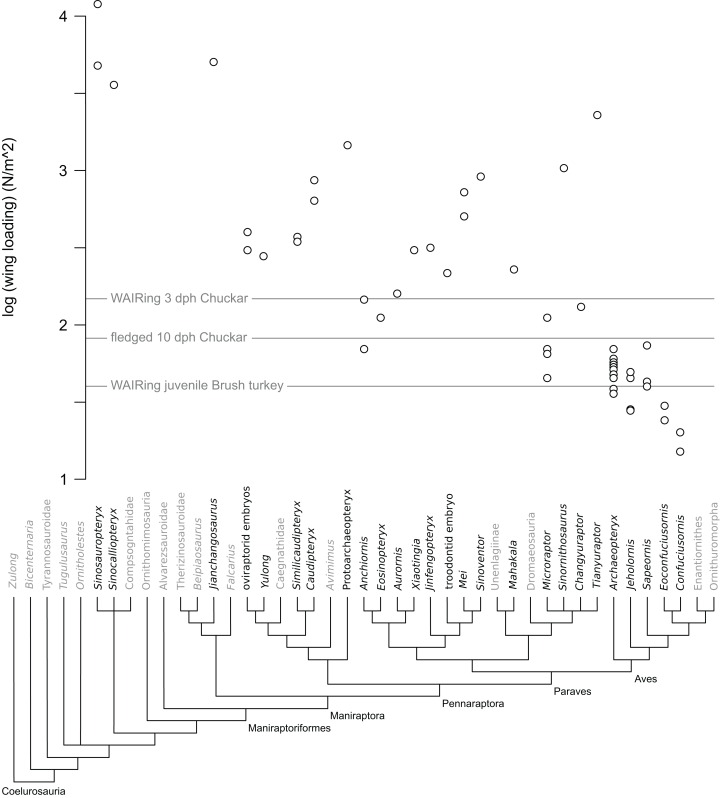
Wing loading values in non-avian theropods.Each open circle denotes the value per specimen for taxa with multiple specimens included in analysis. Note that only a minority of paravian specimens are below the lines denoting values pre WAIR quadruped crawling in Chukar (3 dph) and when fledging occurs (10 dph) as well as WAIR capable Brush Turkeys.